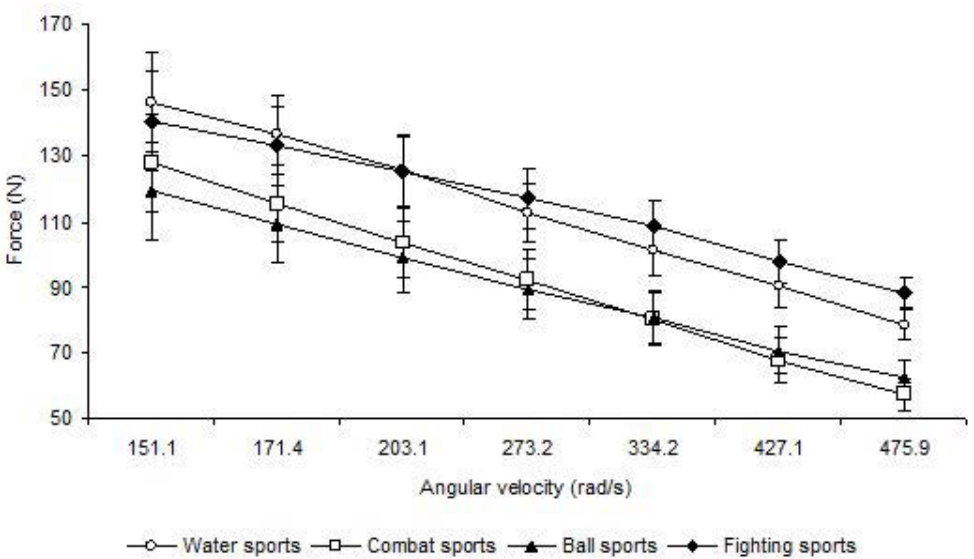
Figure 4. Force during trunk rotations across di ff erent velocities in ball, combat, fighting and water sports athletes.